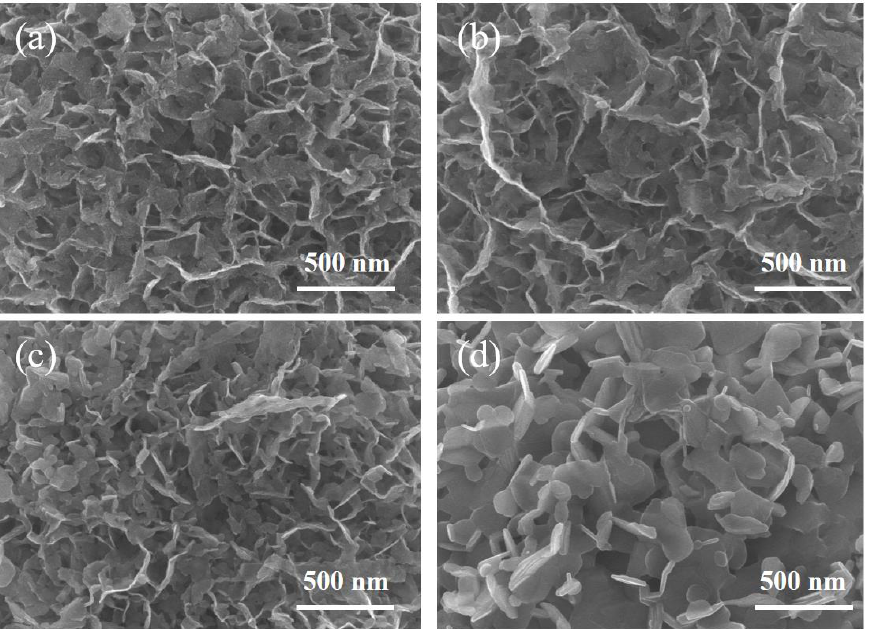
Figure 4. SEM images of Co 9 S 8 /MoS 2 after vulcanization of CoMo-LDH at different temperatures: